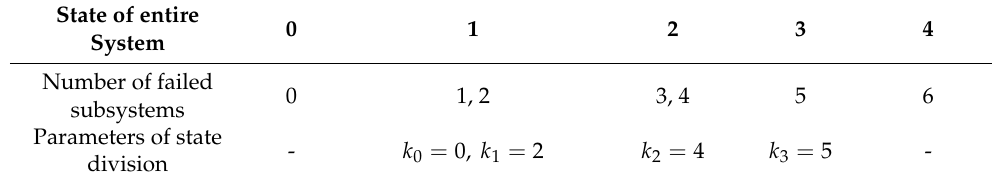
Table 1. Multiple states of entire system and corresponding number of failed subsystems.